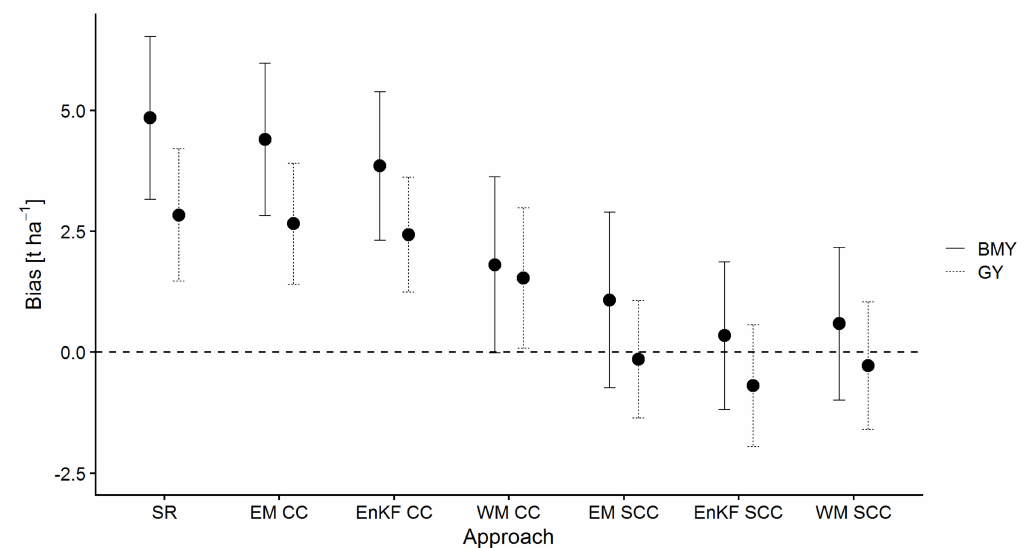
Figure 4. Mean and standard deviation of total aboveground biomass yield (BMY—solid line) and grain yield (GY—dashed line) bias of 14 sites per approach. SR: Standard Run, EnKF: Ensemble Kalman Filter, WM: Weighted Mean, EM: Ensemble Mean, CC: Crop Component Set, SCC: Soil and Crop Component Set. All values in t ha − 1 . Positive values indicate overestimation of the model, negative values indicate underestimation.